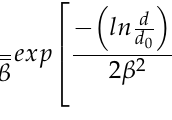
Figure 4. Magnetization versus magnetic field for magnetic fluid, magnetosome chains, and the mixture of magnetic fluid and magnetosomes (ratio 1:1), ( a ) and a zoom resolution where an indication of non-zero coercivity can be observed in the case of magnetosomes ( b ).